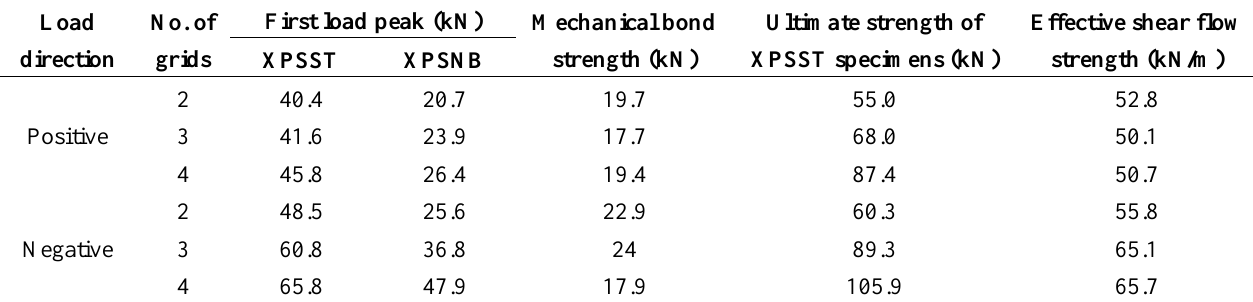
Table 4. Mechanical bond strength and effective shear flow strength according to load direction.